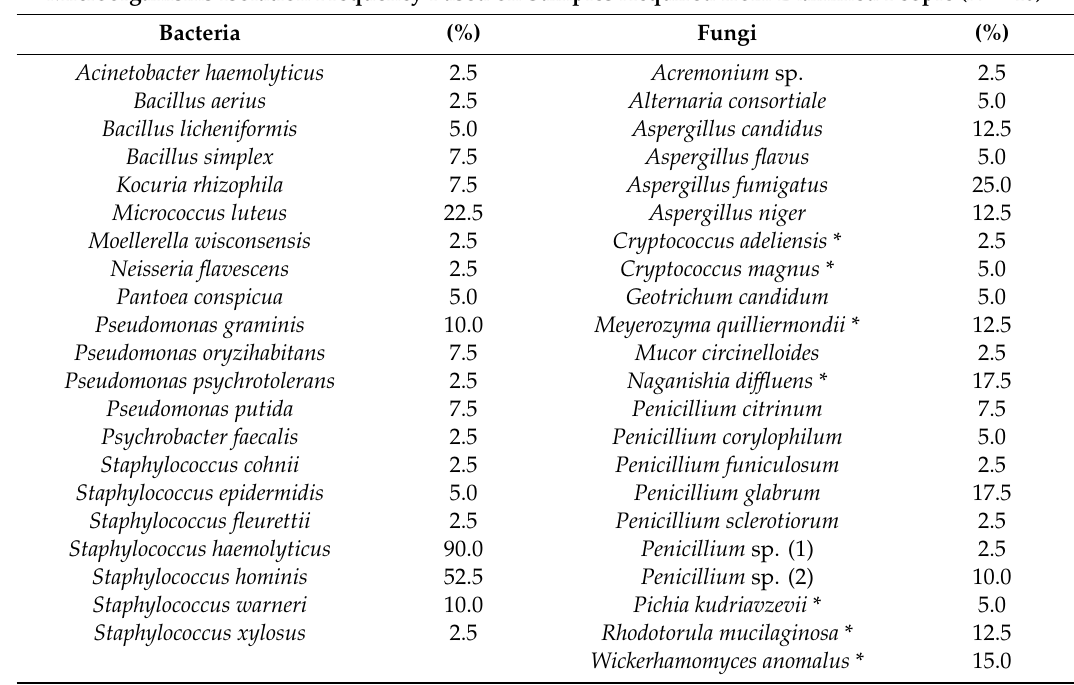
Table 3. Frequency of the microorganisms occurrence on foot